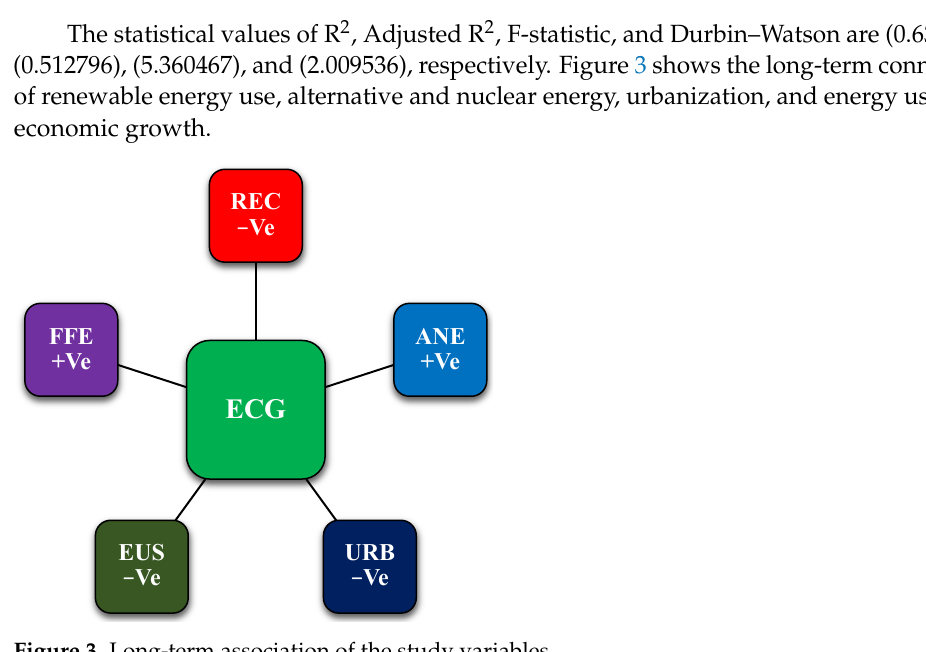
Figure 3. Long-term association of the study variables.